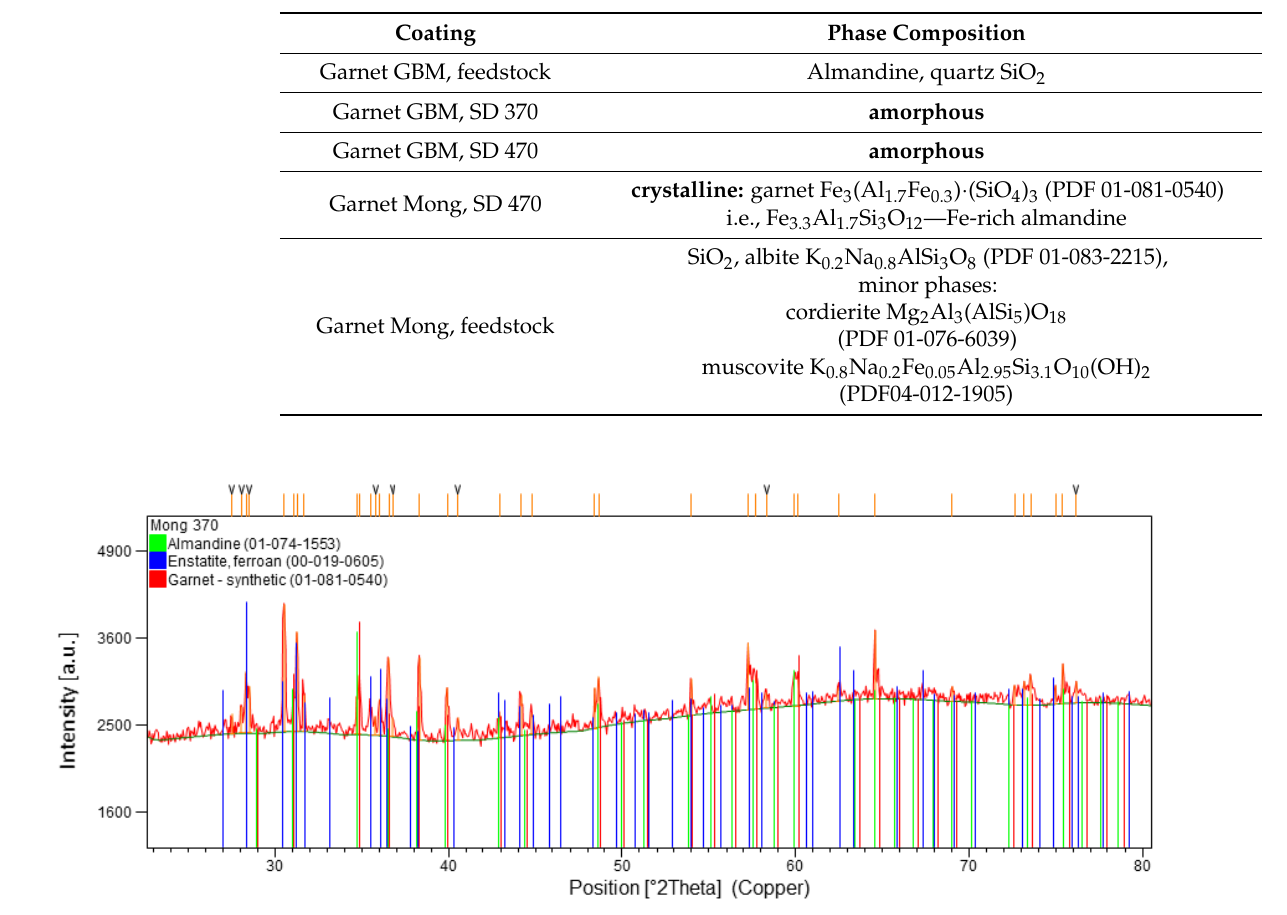
Figure 7. XRD pattern of garnet coating Mong 370.